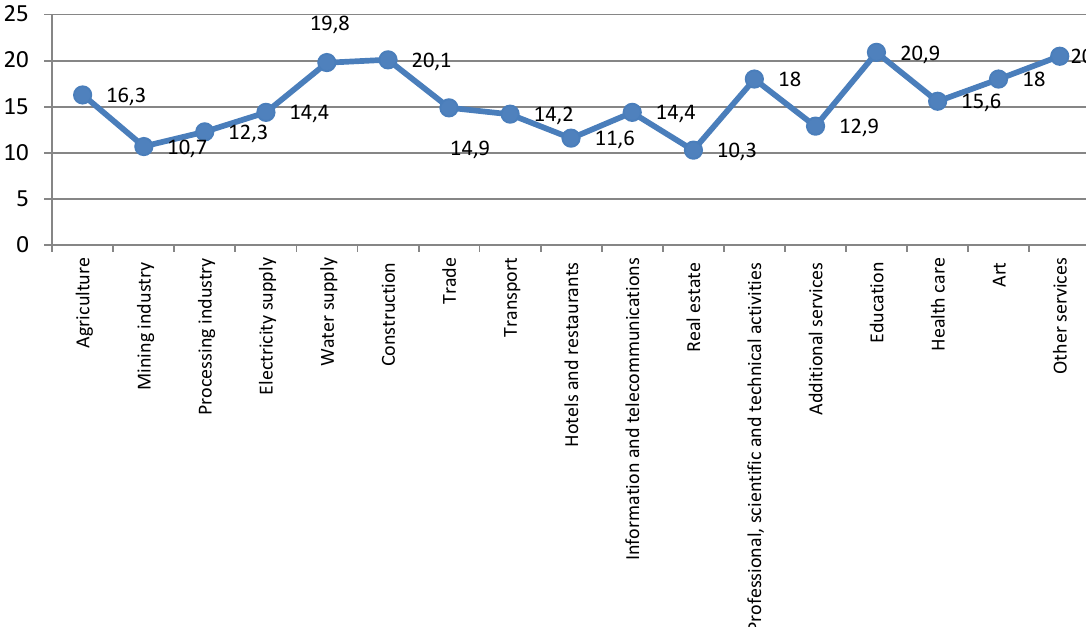
Source: National Bank of Ukraine; World Bank,